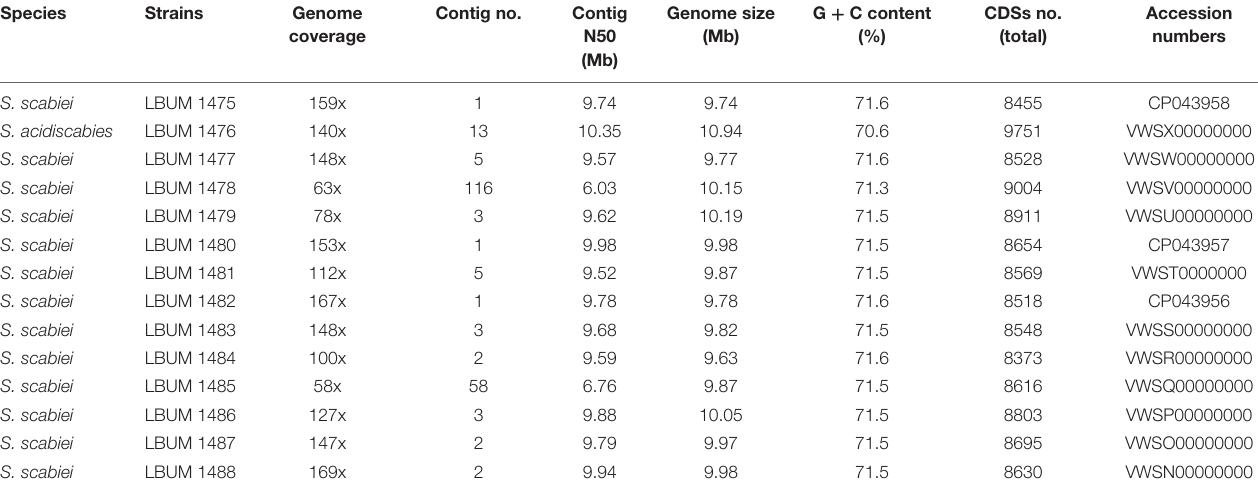
TABLE 1 | General genomic information on the 14 scab-causing Streptomyces spp. under study. Species Strains Genome